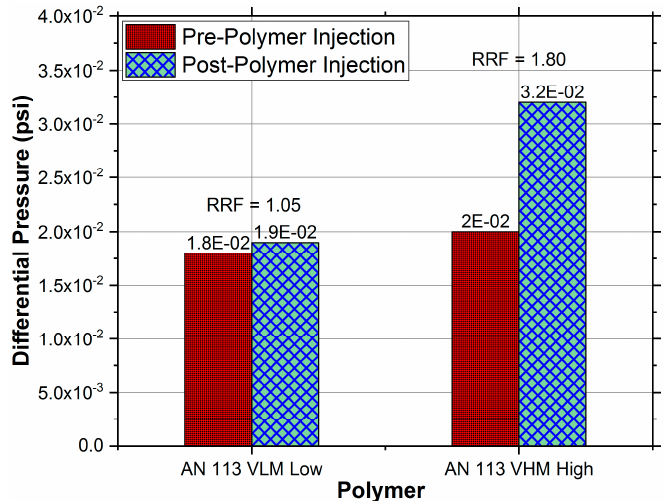
Figure 8. Differential pressures and Residual Resistance Factor (RRF)for pre- and post-polymer